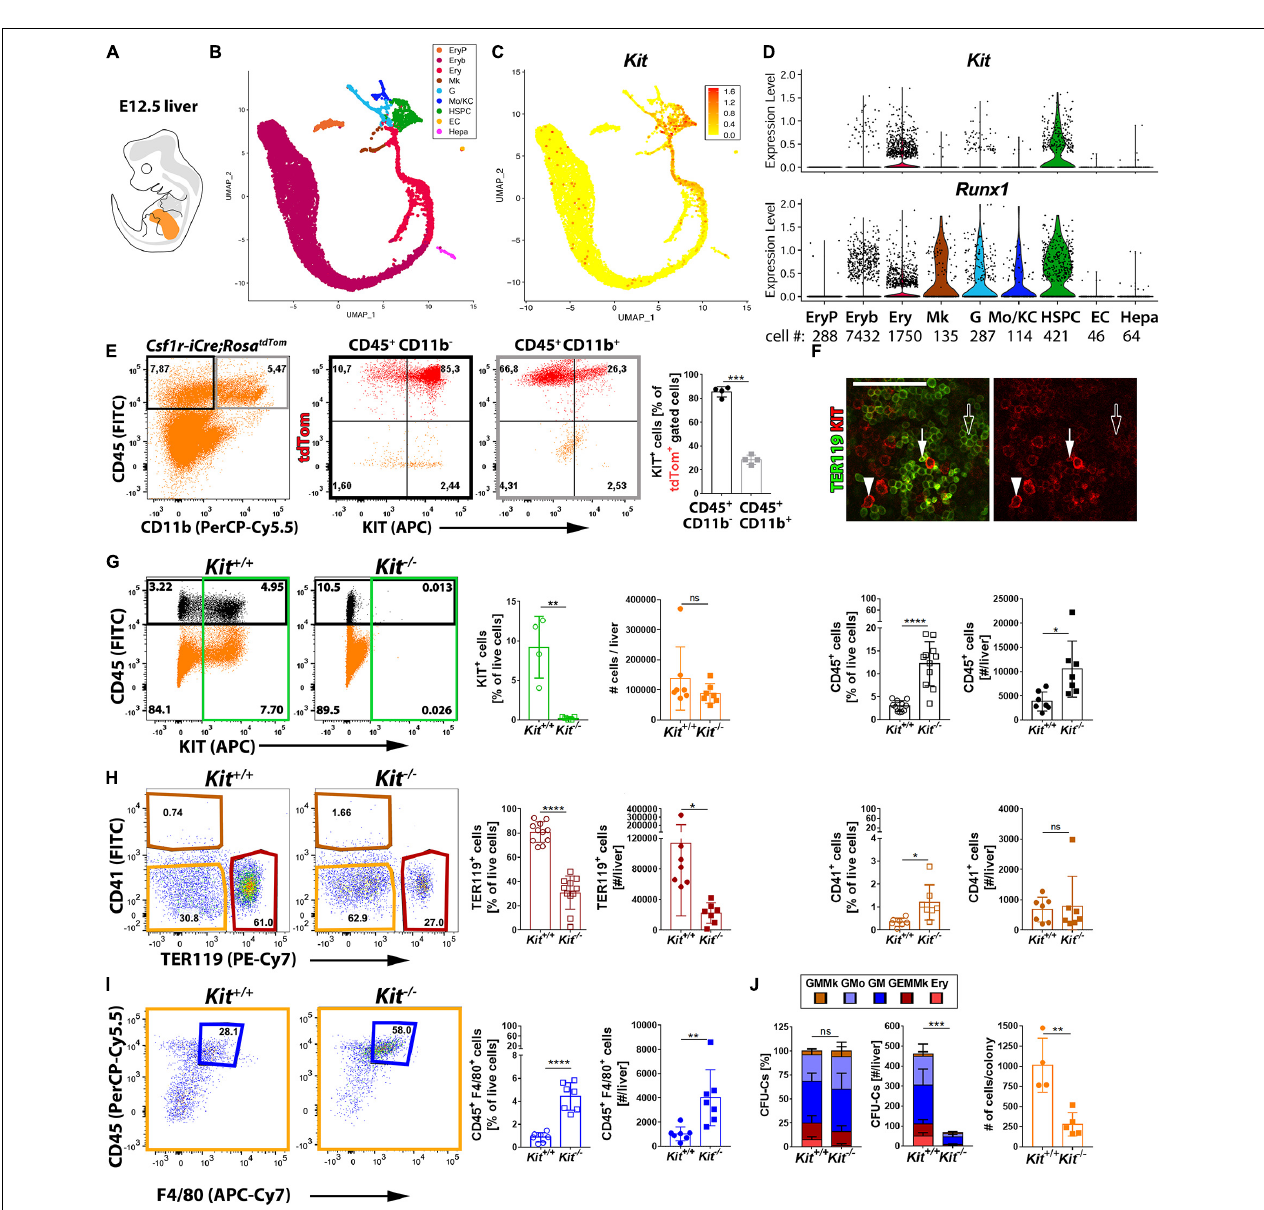
FIGURE 4 | Kit expression profiling and requirement during fetal liver hematopoiesis. (A) Schematic representation of an E12.5 mouse embryo with the fetal liver shown in orange. (B–D) scRNA-seq analysis of E12.5 mouse liver. UMAP plots were used to visualize clusters of distinct cell types (B) and Kit transcript levels in each cell (C) . Violin plots (D) illustrate Kit and Runx1 single-cell transcript levels in each cluster; the number of cells in each cluster is indicated below the violin plots. (E) Flow cytometry analysis of single living cells from E12.5 Csf1r-iCre;Rosa tdTom fetal mouse livers with the indicated markers. The boxes in the left-hand scatter plot indicate the gates used to generate the scatter plots of cells expressing CD45 only (black frame) or CD45 and CD11b (gray frame). The bar graph illustrates that the proportion of KIT + tdTomato + cells is enriched in the CD45 + CD11b − compared to the CD45 + CD11b + population ( n = 4 livers). Data are shown as mean ± SD; each data point represents the value from one liver. *** p < 0.001 (paired Student’s t -test). (F) Whole-mount labeling of E12.5 mouse liver with the indicated markers ( n = 2). White arrowheads indicate KIT + TER119 − hematopoietic progenitors, arrows denote KIT + TER119 + proerythroblasts, and empty arrows indicate KIT − TER119 + erythroblasts; scale bar: 100 µ m. (G–I) Flow cytometry analysis of single living cells from E12.5 Kit − / − and Kit + / + littermate mouse livers with the indicated markers. The color-coded boxes in the scatter plots indicate the gates used to analyze specific cell populations, shown in corresponding colors in the bar charts. Data are shown as mean ± SD; each data point represents the value from one liver; ns, non-significant, * p < 0.05, ** p < 0.01, **** p < 0.0001 (unpaired Student’s t -test). (G) Loss of KIT + cells in Kit -null mutants (green; n = 4 wild types and n = 5 mutants), total cell number (orange: n = 7 each) and percentage as well as the number of CD45 + cells in each liver (black; n = 11 and n = 7 each, respectively). (H,I) Quantification of percentage as well as the number of TER119 + CD41 − erythroid cells (red; n = 11 and n = 7 each, respectively) and CD41 + TER119 − megakaryocytes (brown; n = 7 each). The double-negative population (orange) was further analyzed to identify CD45 + F4/80 + macrophages (blue; n = 7 each). (J) Quantification of the percentage (left panel), number (center panel), and colony cell number (right panel) of CFU-C in Kit + / + versus Kit − / − littermate E12.5 livers ( n = 4 wild types and n = 5 mutants). Each data point represents the value from one embryo; stacked bar graph data are shown as mean ± SEM; ns, non-significant; *** p < 0.001 (two-way ANOVA); bar graph data are shown as mean ± SD; ** p < 0.01 (unpaired Student’s t